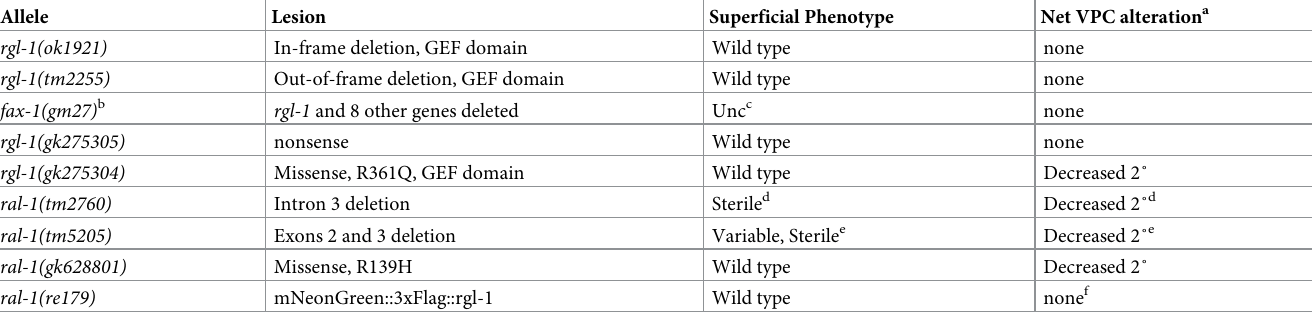
Table 1. rgl-1 and ral-1 alleles and mutant